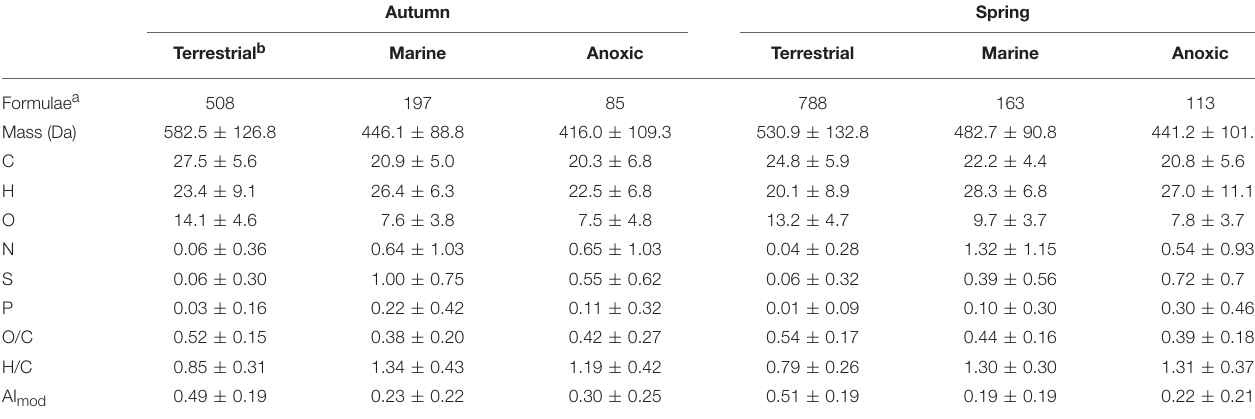
a Number of enriched molecular formulae (“Formulae”), intensity-weighted means of molecular masses of enriched molecular formulae (“Mass,” in Dalton), intensity-weighted means of the number of atoms per molecular formula (C, H, O, N, S, P), molar ratios (O/C, H/C), and of aromaticity index (AI mod ). b Stations Mo14 and At-4 (surface of Bothnian Bay close to Kalix River outflow; terrestrial DOM endmembers), S4 (19m depth in Kattegat) and S1 (surface close to Skagerrak; marine DOM endmembers) and TF284 (Landsort Deep in 430m depth; anoxic DOM endmembers) were used for the autumn and spring samples, respectively. See Figure 1 for sampling positions and Figure 7 for distribution of clusters in